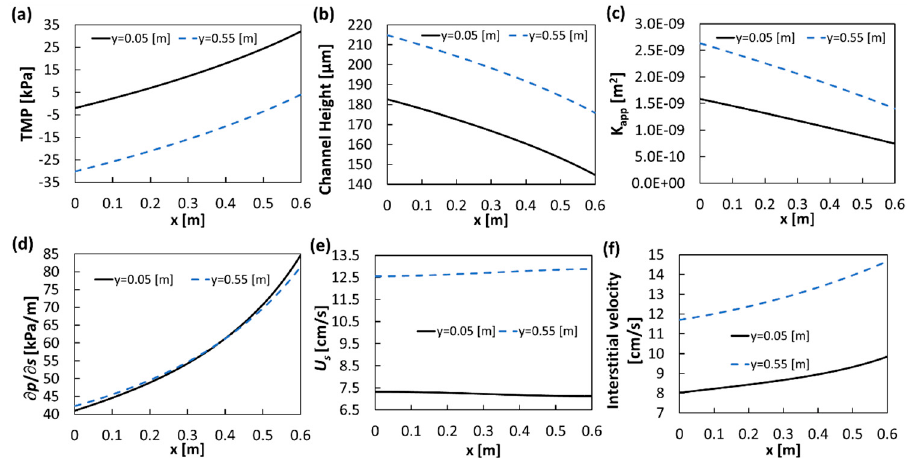
Figure 13. Results for a cross flow stack of 0.6 m sides at P in − P out = 34.3 kPa ( U s ≈ 10 cm / s) in the presence of membrane deformation: profiles of TMP ( a ), and concentrate channel equivalent height ( b ), apparent permeability ( c ), pressure gradient ( d ), superficial velocity ( e ) and interstitial velocity ( f ) along the x direction at y = 0.05 and 0.55 m. Corresponding results would be obtained for the diluate channel.